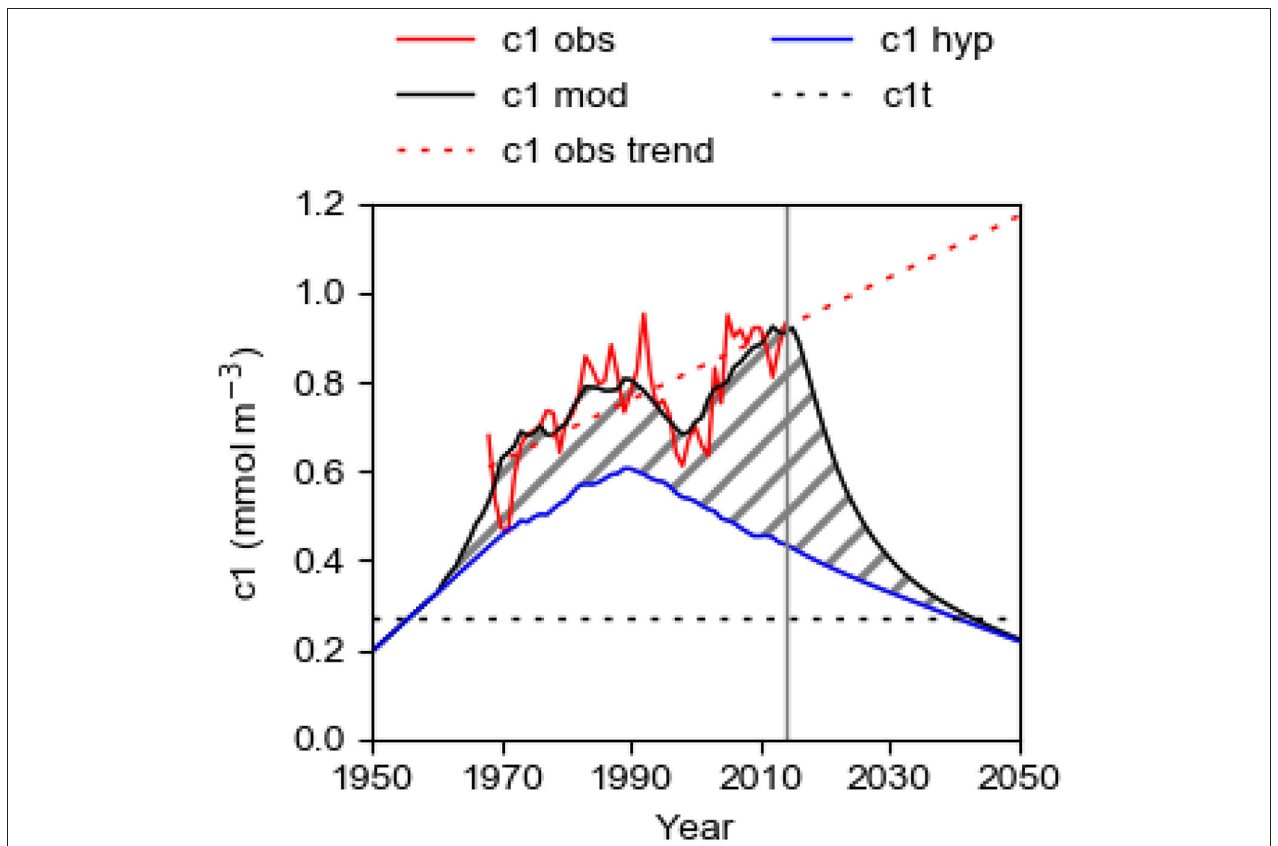
FIGURE 10 | Computational results from the best fit model for the period 1950–2014 (2014 marked by vertical line) with the internal source IPS turned on ( c1mod with fs = 1.22) and turned off ( c1hyp with fs = 0, blue line). Also shown is the observed c1obs (red line) for the period 1968–2014. The shaded area shows the estimated contribution to c1 by the IPS . In the computation for the period 2015–2050, IPS is shut off (full-drawn black line). The blue line shows the computed hypothetical evolution c1hyp with IPS shut off for the whole period 1950–2050. Also shown is the linear trend c1obstrend of c1obs (determined by the least square method for the period 1968–2018) which is extrapolated to 2050, and the threshold concentration c1t = 0.27 mmol m − 3